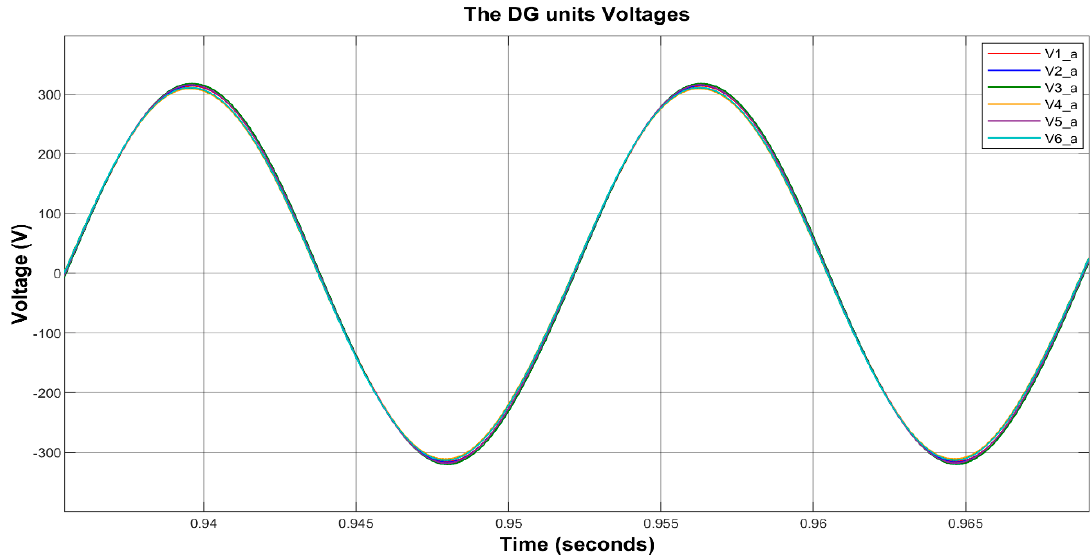
Figure 14. The DG units’ active powers for Case 2.